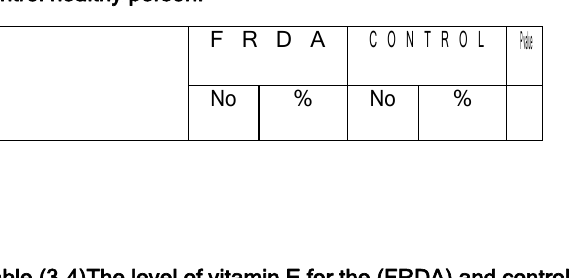
The results in the table 3.4 showed that level of vitamin E were (10.47±1.79) ,(11.48±2.61) and (10.66±1.26) in patients less than 10 years , patients between 10-19 years, and for those equal or more than 20 years of age respectively, (p=0.382), See the table (3-4).The level of vitamin E in control patients were ( 30.57±4.61), (27.46±3.16) and(25.50±3.03) for patients less than 10 years age, patients between 10-19 years, and for those